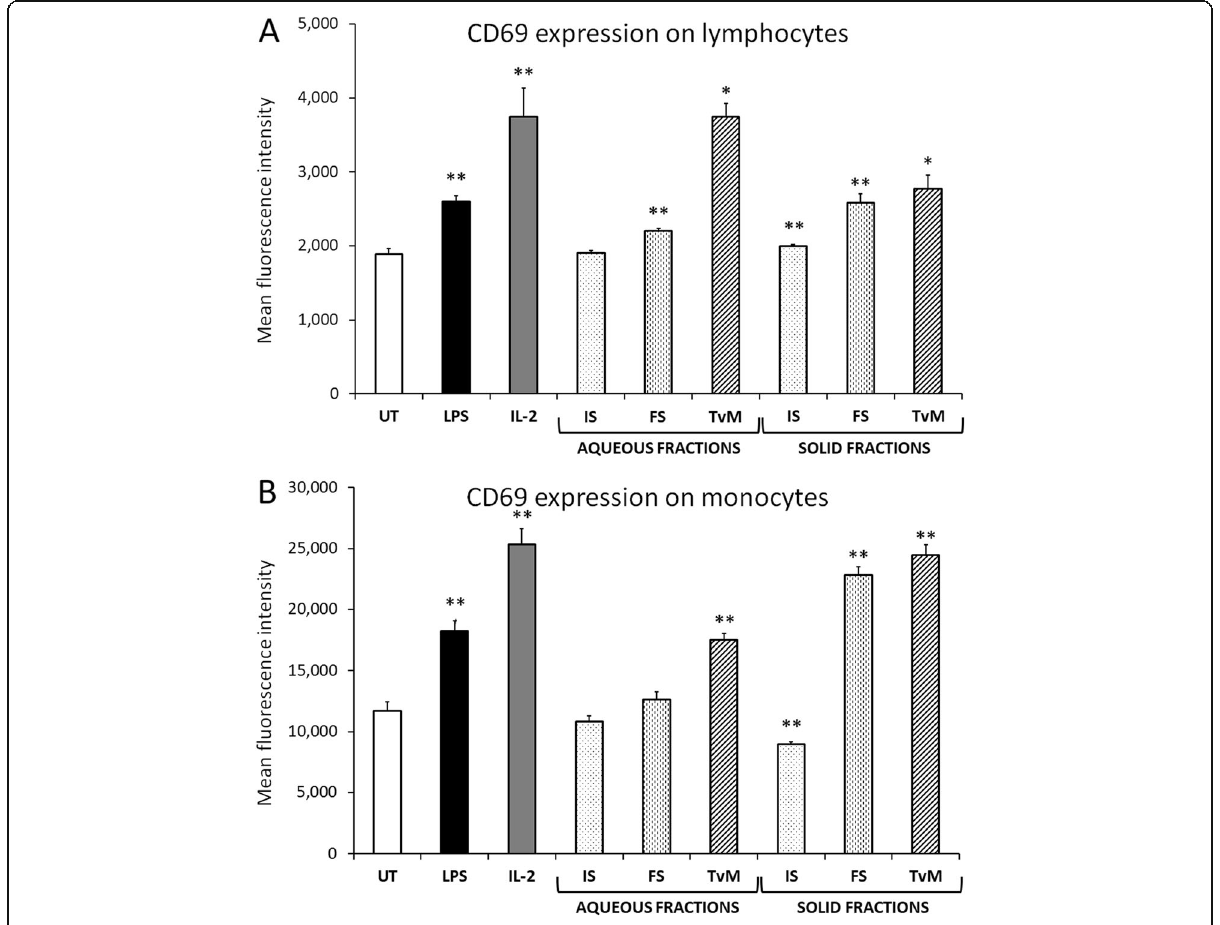
Fig. 3 Induction of the CD69 cellular activation marker on lymphocyte ( a ) and monocyte ( b ) subsets in human PBMC cultures. The PBMC cultures were treated for 24 h in the presence of the aqueous versus solid fractions of initial substrate (IS), fermented substrate (FS), and Trametes versicolor mycelium (TvM). Data are shown for the highest dose tested (2 mg/mL), where the dose represents the amount of starting material used to produce a given fraction. Data are presented as mean ± standard deviation of the mean fluorescence intensities in triplicate cultures, and represents one of three separate experiments using PBMC cells from three different healthy human donors. Positive controls included lipopolysaccharide (LPS, 10 ng/mL) and Interleukin-2 (IL-2, 100 IU/mL). Statistical significance is indicated as * for P < 0.05 and **for P <